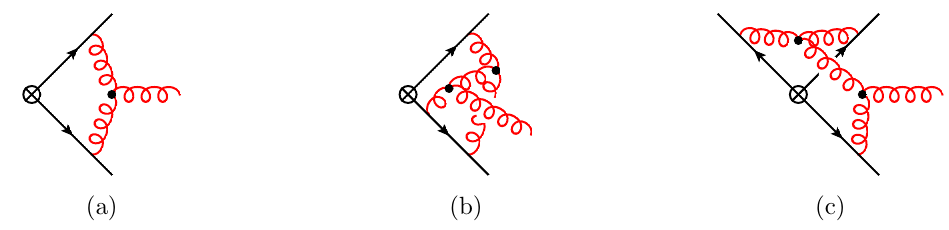
Figure 1. Representative diagrams for the (a) one-loop, (b) two-loop dipole, and (c) two-loop tripole soft